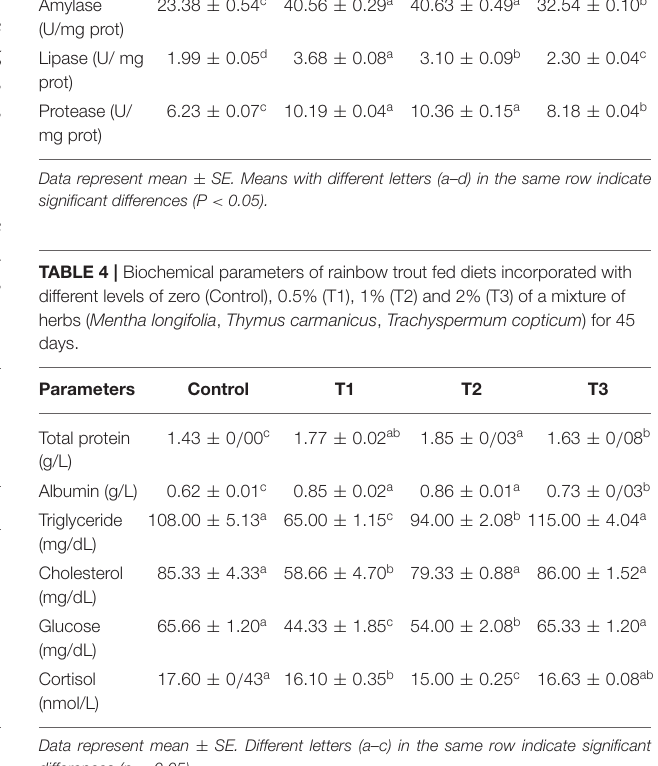
Data represent mean ± SE. Different letters (a–c) in the same row indicate significant differences (p < 0.05).